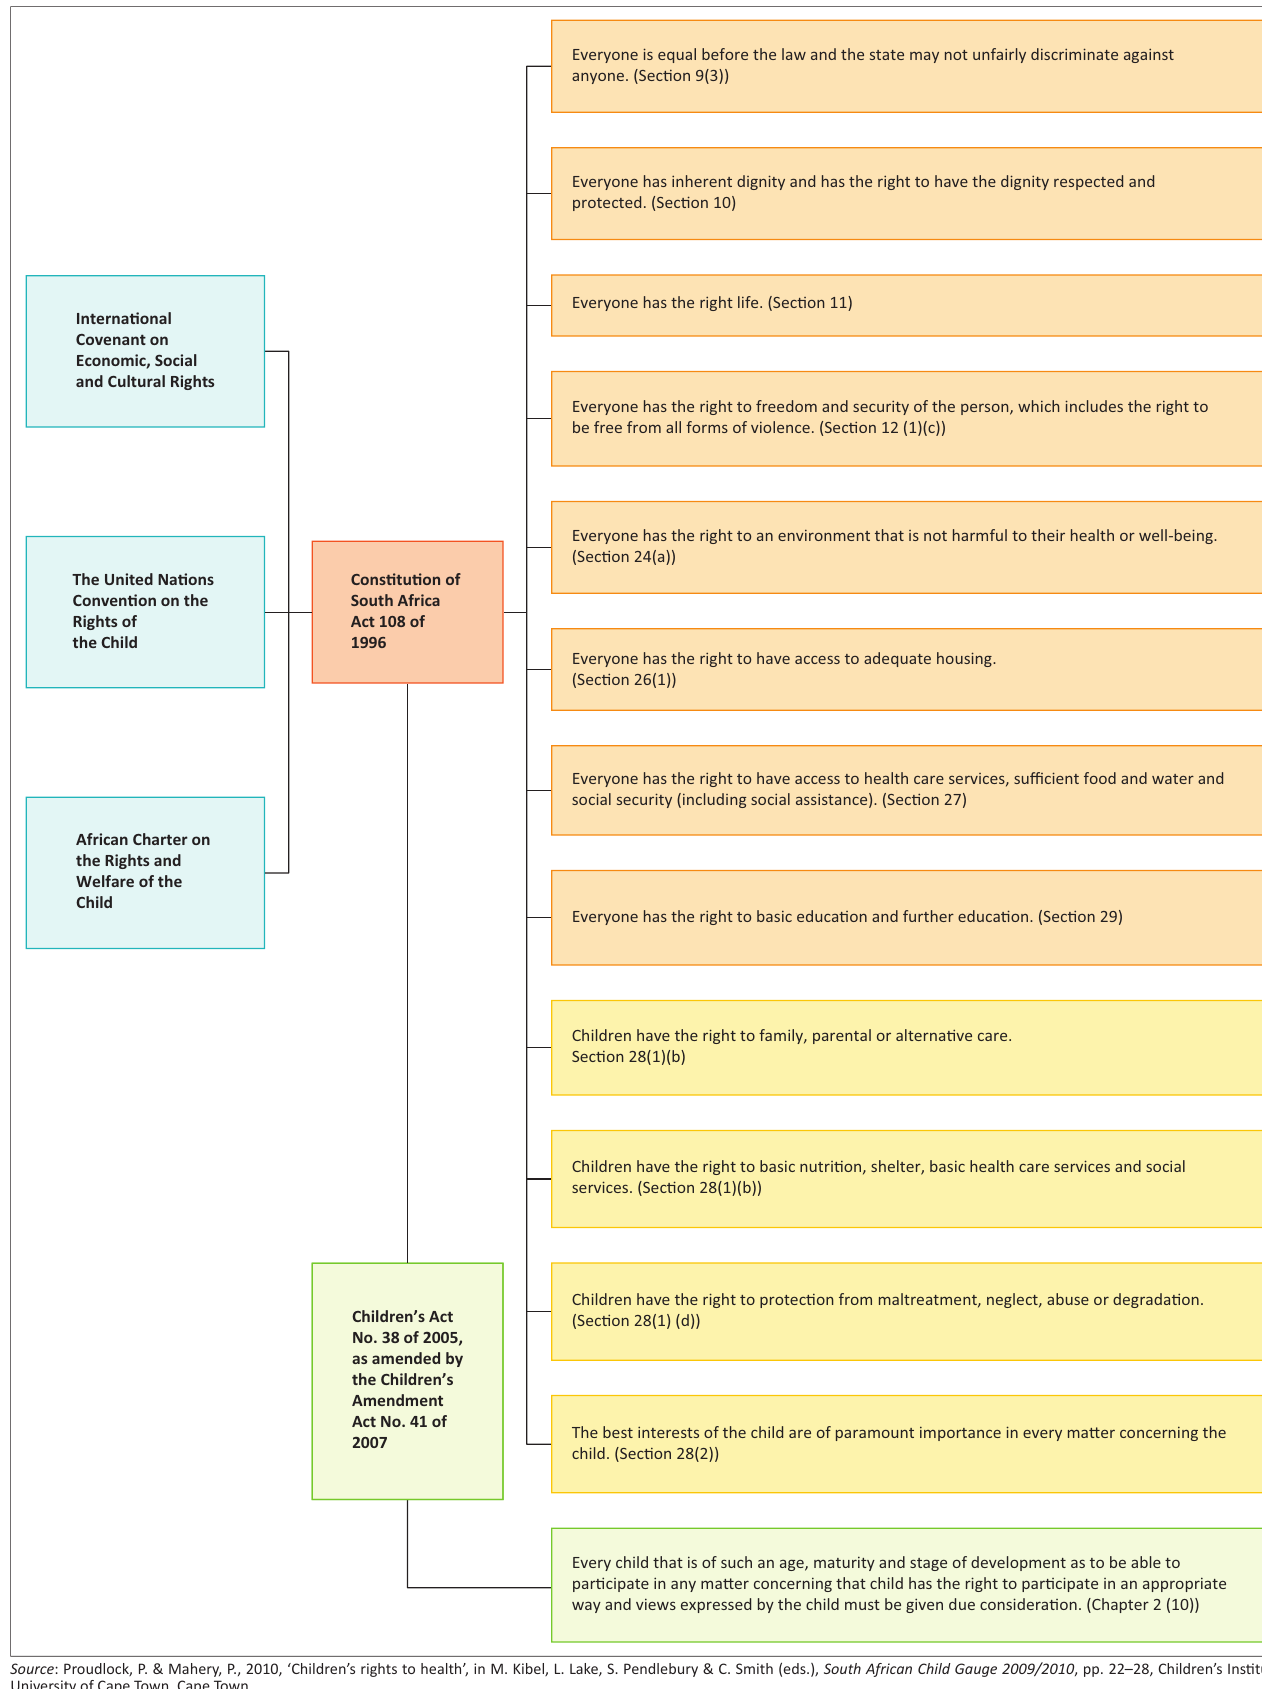
FIGURE 1: How the Constitution and Children’s Act give effect to children’s international rights to